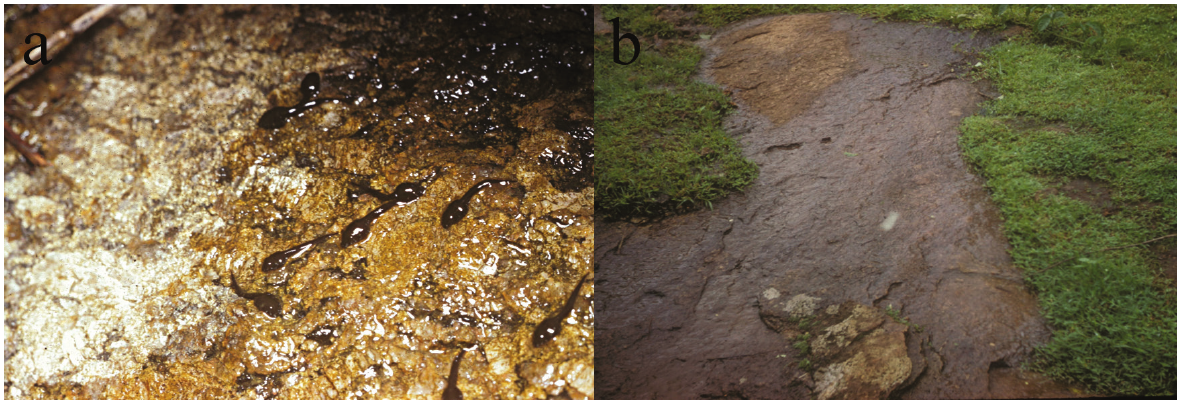
Figure 1. Habitat (right) of Amietophrynus perreti tadpoles (left) at the type locality, the Idanre Hills in Nigeria (photos: courtesy of A.